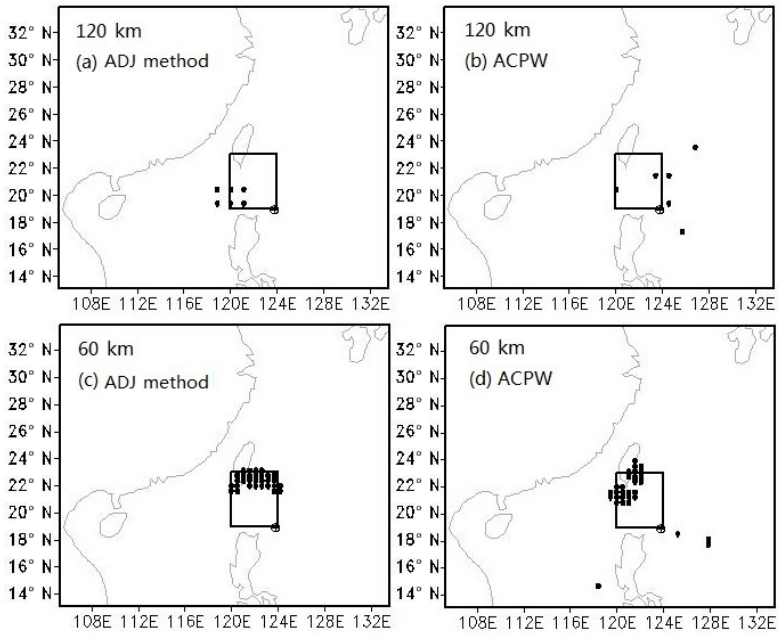
Figure 14. Sensitive regions identified by the CNOPs with 6 points at the 120km resolution and 30 points at the 60km resolution for TC Fitow. The squares indicate the verification areas, and the initial cyclone positions are shown as ⊕ . Letters (a) and (b) denote the CNOP patterns at the 120km resolution for the ADJ method and the ACPW algorithm, respectively, while letters (c) and (d) represent the CNOP patterns at the 60km resolution for the ADJ method and the ACPW algorithm,